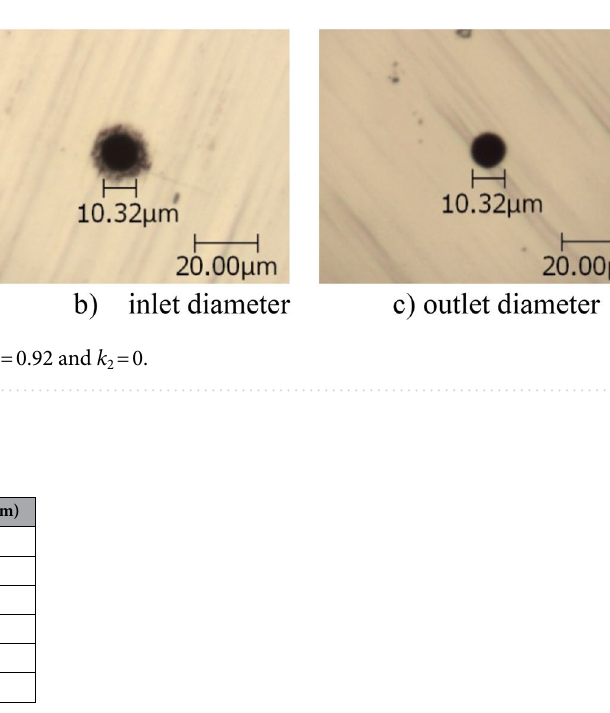
Table 1. Micro holes produced for various k 1